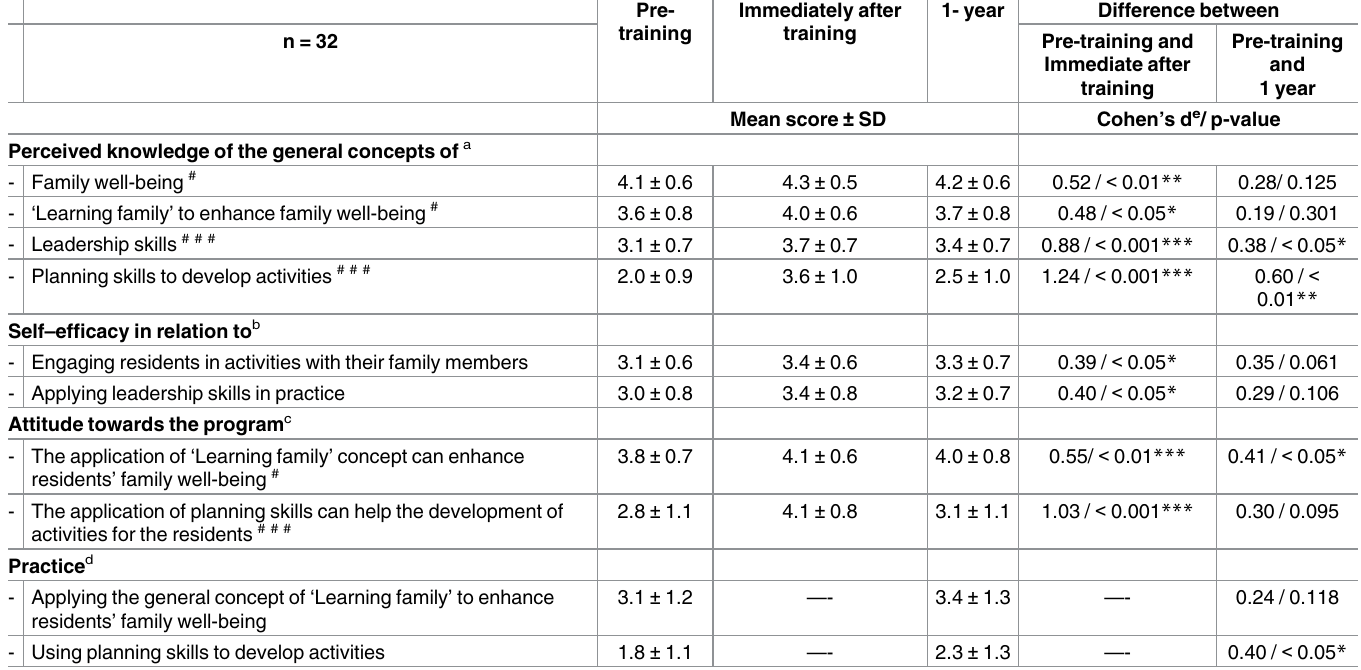
Table 5. Trainees’ perceivedknowledge, self-efficacy, attitude and practice on each component of Learning Families Project: Intention-to-treat analysis.